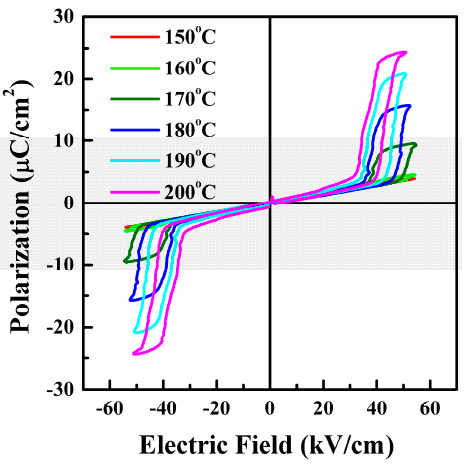
Figure 3. P-E hysteresis loops of PLZT2/95/5 ceramics measured at different temperatures but fixed frequency, 10 Hz, under electric field 55 kV/cm.